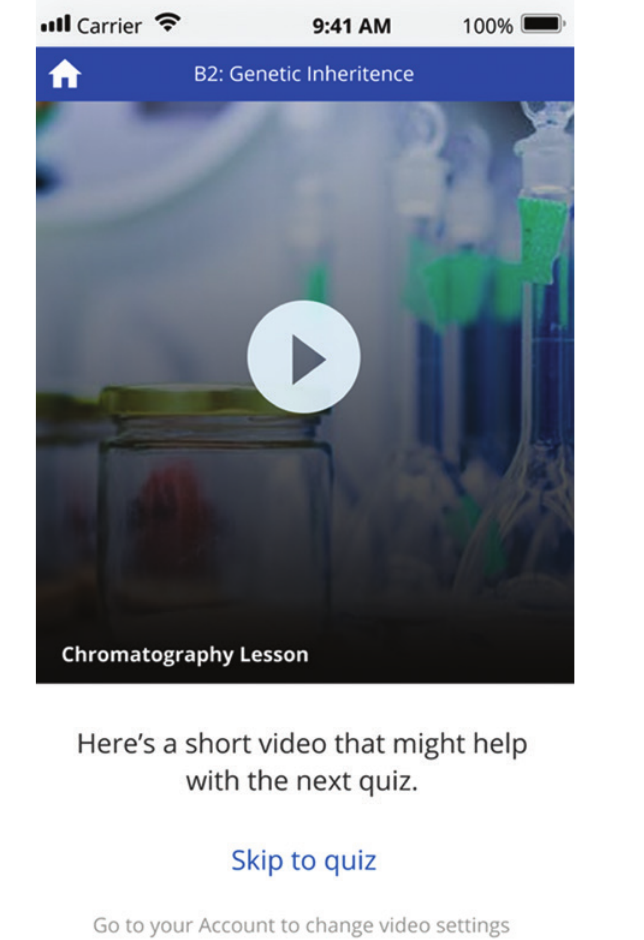
figure 3: example video prompt (illustrative design prototype) (source: